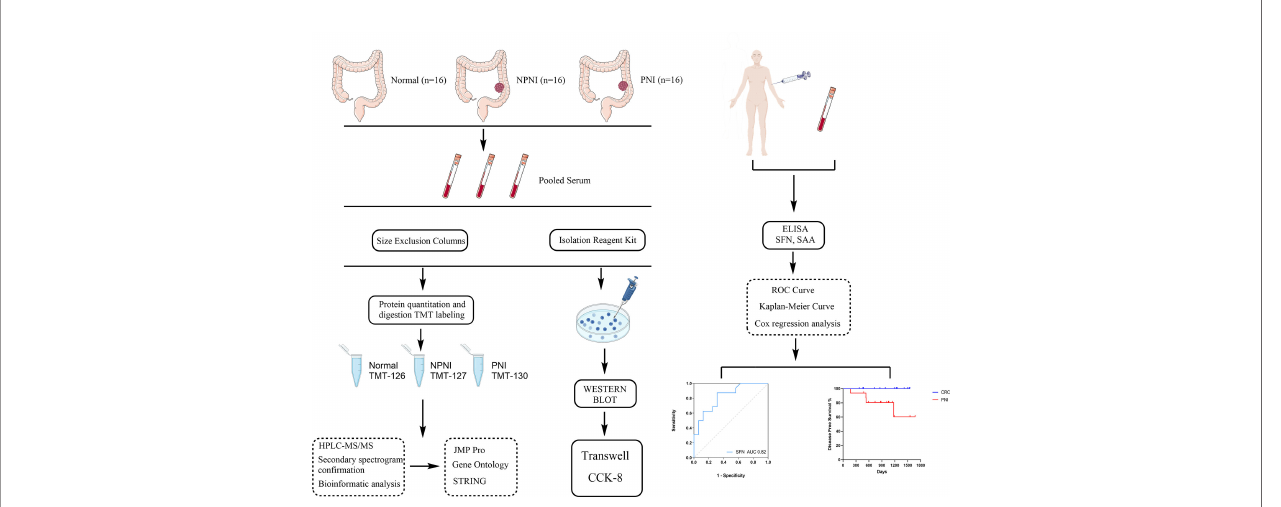
FIGURE 1 | Schematic diagram of the experimental work fl ow employed in this study. The rectangular frame describes the analytical steps and tools employed in the proteomic study (see the “ Methods ” section for full details). PNI, perineural invasion; NPIN, non-perineural invasion; TMT, tandem mass tag; HPLC, high-performance liquid chromatography; mass spectrometry/mass spectrometry; DEP, differentially expressed protein; GO, gene ontology; ROC, receiver operating